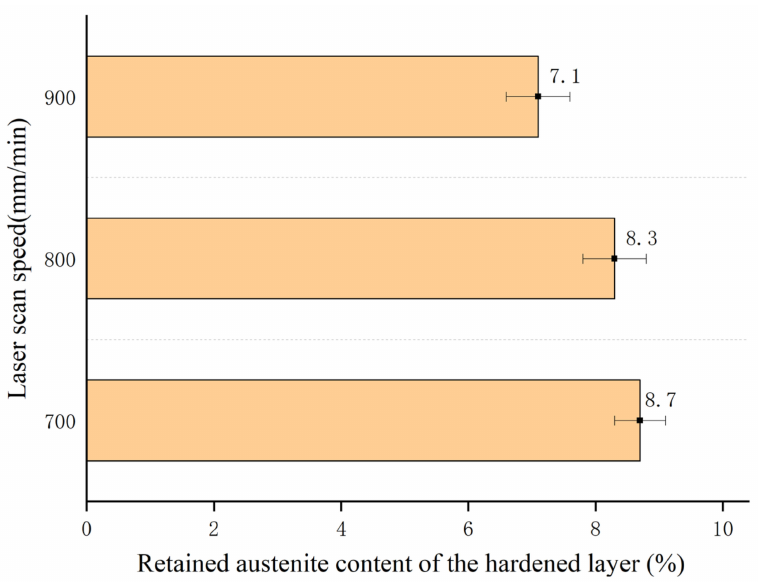
Figure 16. Retained austenite content of the hardened layer after different laser scanning